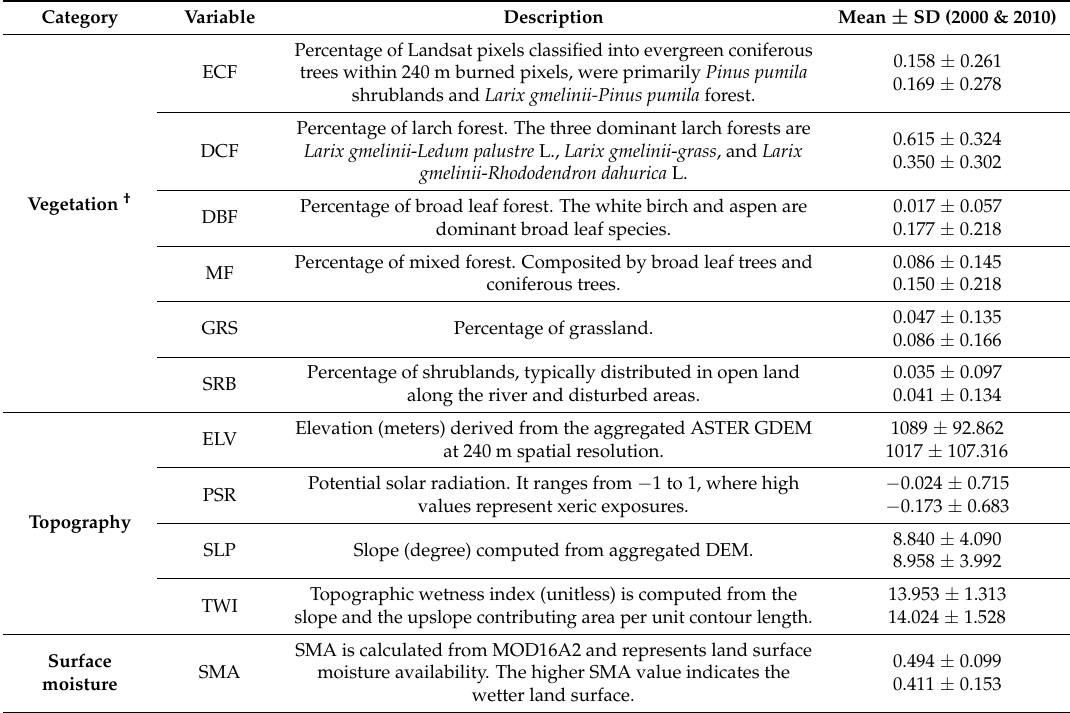
Table 2. Abbreviations and descriptions of explanatory variables in this